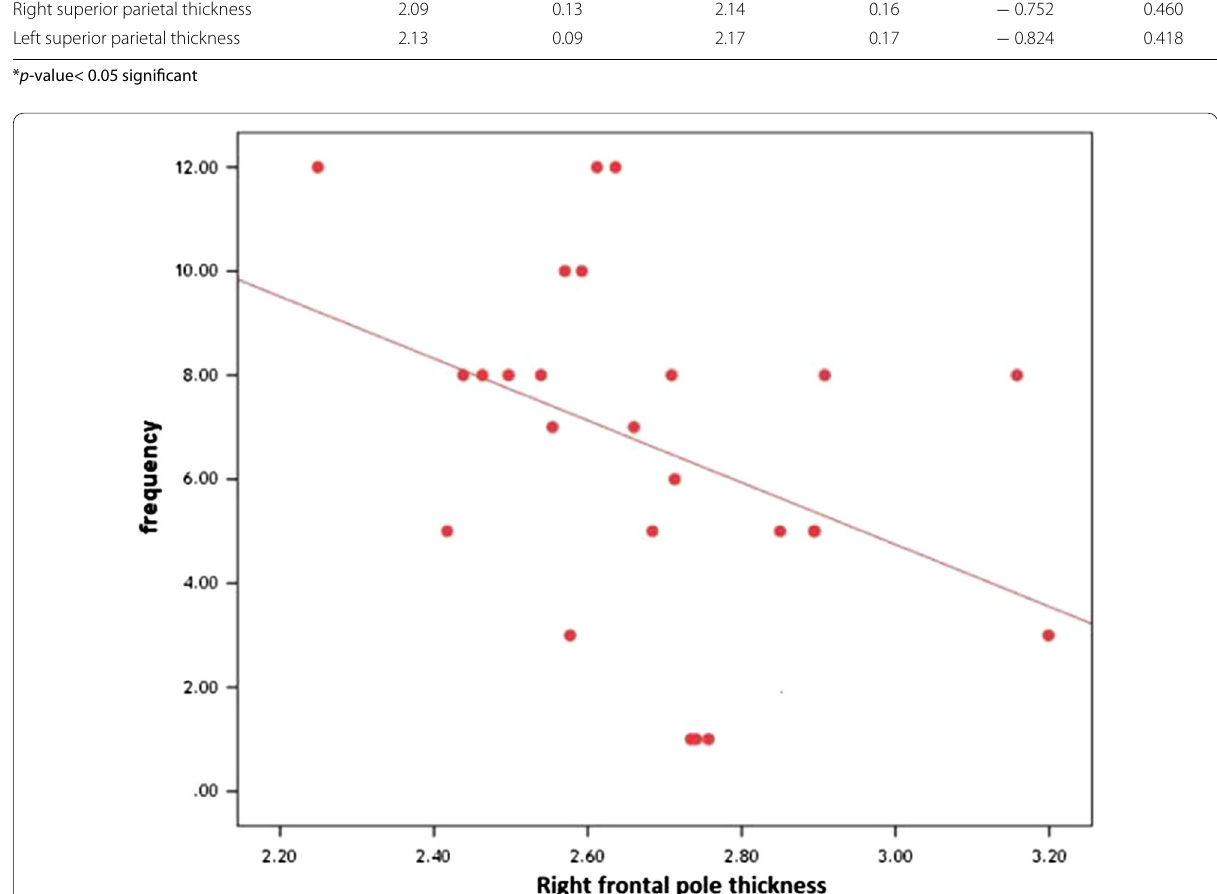
Fig. 2 Negative significant correlation between frequency of attacks and right frontal pole